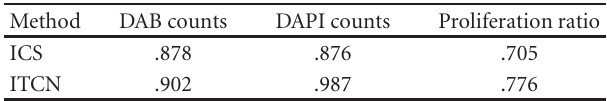
Table 2: Correlations for automated counts with the mean manual count and the ratio of proliferation. All are significant at P < .